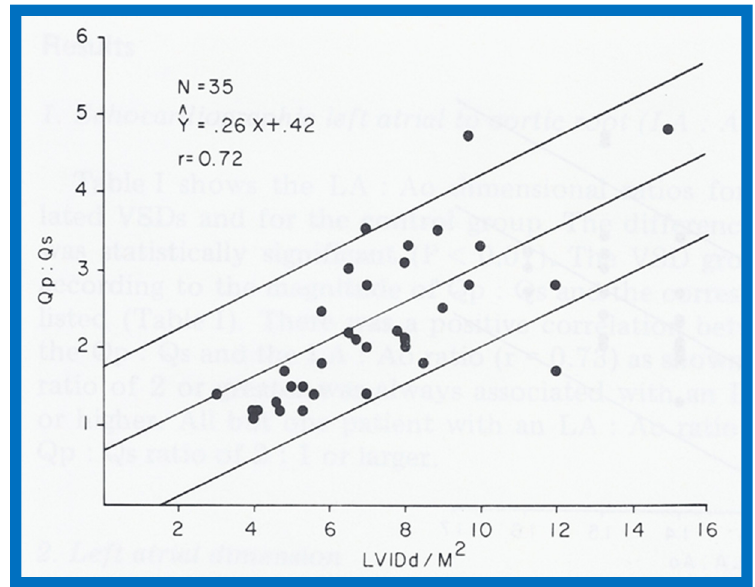
Figure 3. Scattergram demonstrating the relationship of left ventricular internal dimension / m 2 (LVIDd / m 2 ) with pulmonary-to-systemic flow ratio (Qp:Qs) in patients with isolated ventricular septal defects. The central lines and insert are as in Figure 1. Reproduced from Rees AH, Rao P.S., et al. [1].